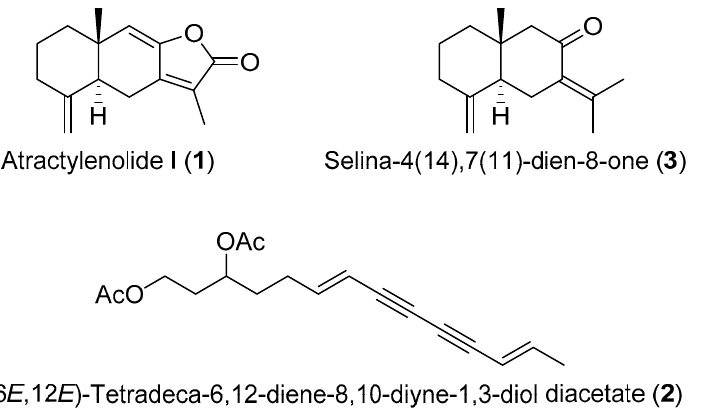
Figure 1. Chemical structures of purified compounds 1 – 3 .